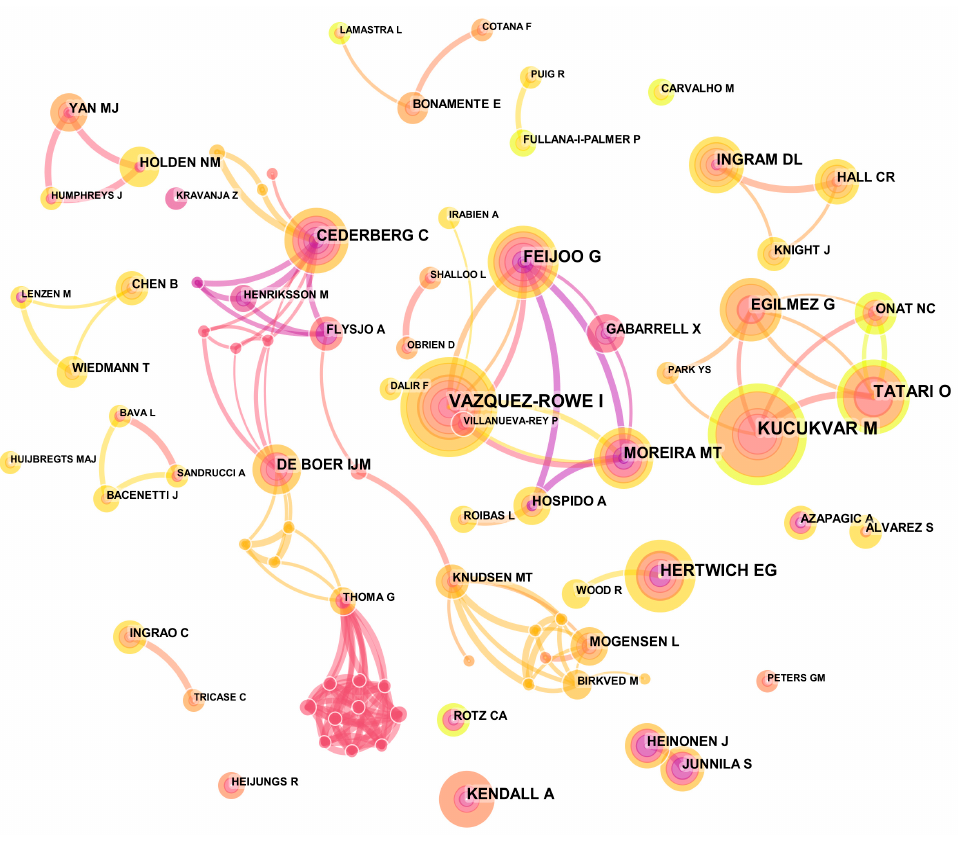
Figure A5. Author collaboration network.